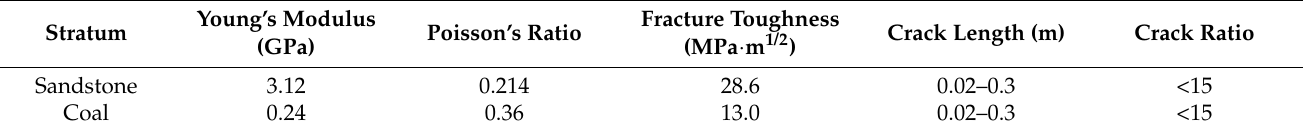
Table 2. Mechanical parameters of rock mass.